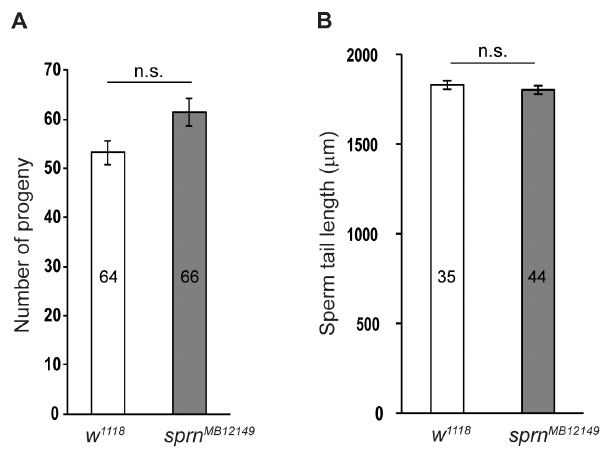
Figure 5. Sprn mutant males have normal fertility and sperm tail length. (A) The number of progeny produced by single w 1118 or sprn MB12149 males in the fertility test. The sprn MB12149 mutant males produced more progeny, but the difference was not significant according to Student’s t test (p=0.0905). Error bars represent standard error of the means (SEM), numbers inside the bars indicate the total number of males tested. (B) sprn MB12149 has normal sperm tail length compared to wild-type ( w 1118 ). Error bars represent standard error of the means (SEM), Student’s t test was used to determine the statistical significance (p=0.438). Values inside the bars indicate the total number of sperm that were measured.